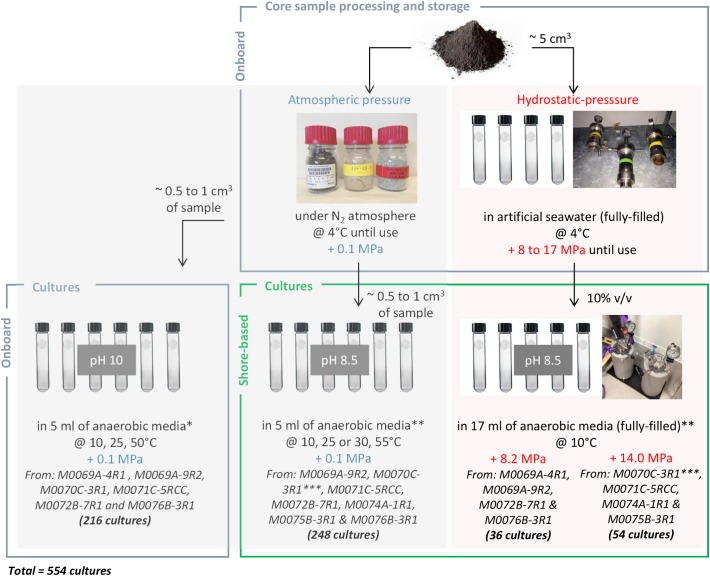
Schematic view of the sampling processing and the cultures initiated at 0.1, 8.2 and 14.0 MPa, onboard and onshore. A total of 554 cultures was performed, in duplicate (except if too small rock quantity); controls were uninoculated tubes. ∗Fermentation (F); acetotrophic (MAcH2), hydrogenotrophic (MH2), and methylotrophic (MMet) methanogenesis; acetotrophic (SAc) and hydrogenotrophic (SH2) sulfate reduction. ∗∗Fermentation (F1), oligotrophy (F2), sulfate reduction from acetate or lactate (SRB1) and formate or H2/CO2 (SRB2), methanogenesis by acetoclasty or methylotrophy (MET1) and hydrogenotrophy (MET2), and iron reduction (FE) (Supplementary Table 2). ∗∗∗Black basaltic and white carbonated parts dissociated.